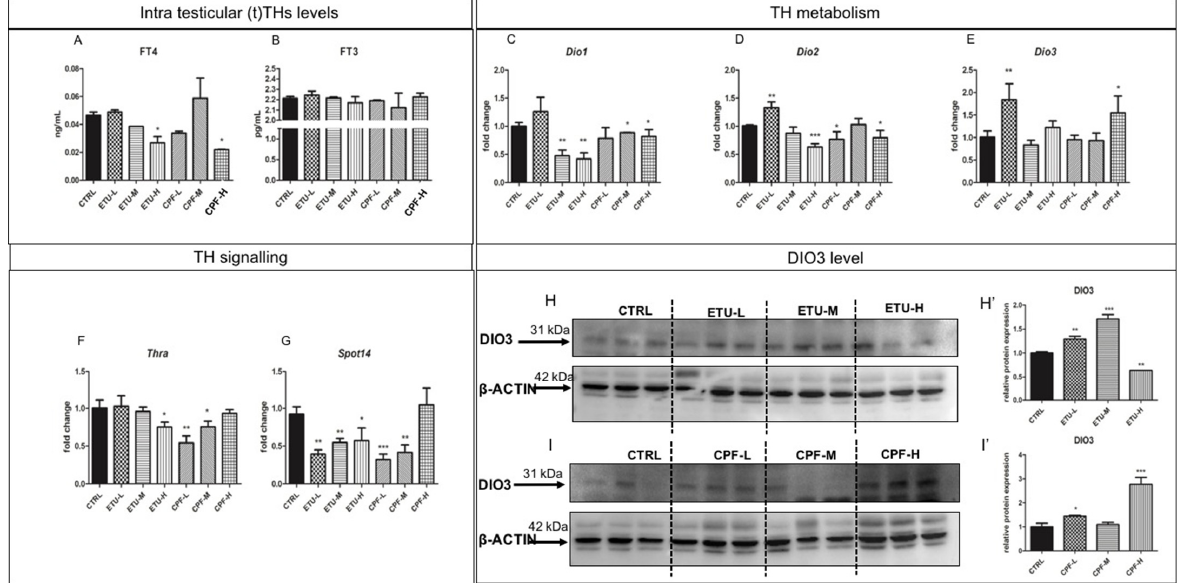
Figure 2. Developmental exposure to CPF and ETU modulates THs levels and metabolism in mouse testis. ( A , B ) Testicular (t)FT4 and (t)FT3 levels were measured by ELISA in adult testes from CTRL and exposed males (N ◦ = 3 testis/group), as described in M&M section. ( C – G ) Levels of the mRNAs of enzymes involved in THs metabolism ( Dio1 , Dio2 , Dio3) and signaling ( Thra , Spot14 ) in testes of mice exposed to pesticides and CTRL. RTqPCR tests were performed on three biological samples ( n = 3 testis/group). Data are reported as fold change values calculated as a ratio between average relative gene expression in treated and control testes, after normalization on β -actin mRNA. ( H , H’ , I , I’ ) Western blot analysis showing the level of DIO3 protein following ETU and CPF treatment (N ◦ 3 testis/group). Data were obtained normalizing using B-ACTIN. Data analysis was conducted as described in M&M. One-way ANOVA (post hoc test: Dunnett’s) was used. * p < 0.05, ** p < 0.01, *** p < 0.001. Mean and standard deviation are